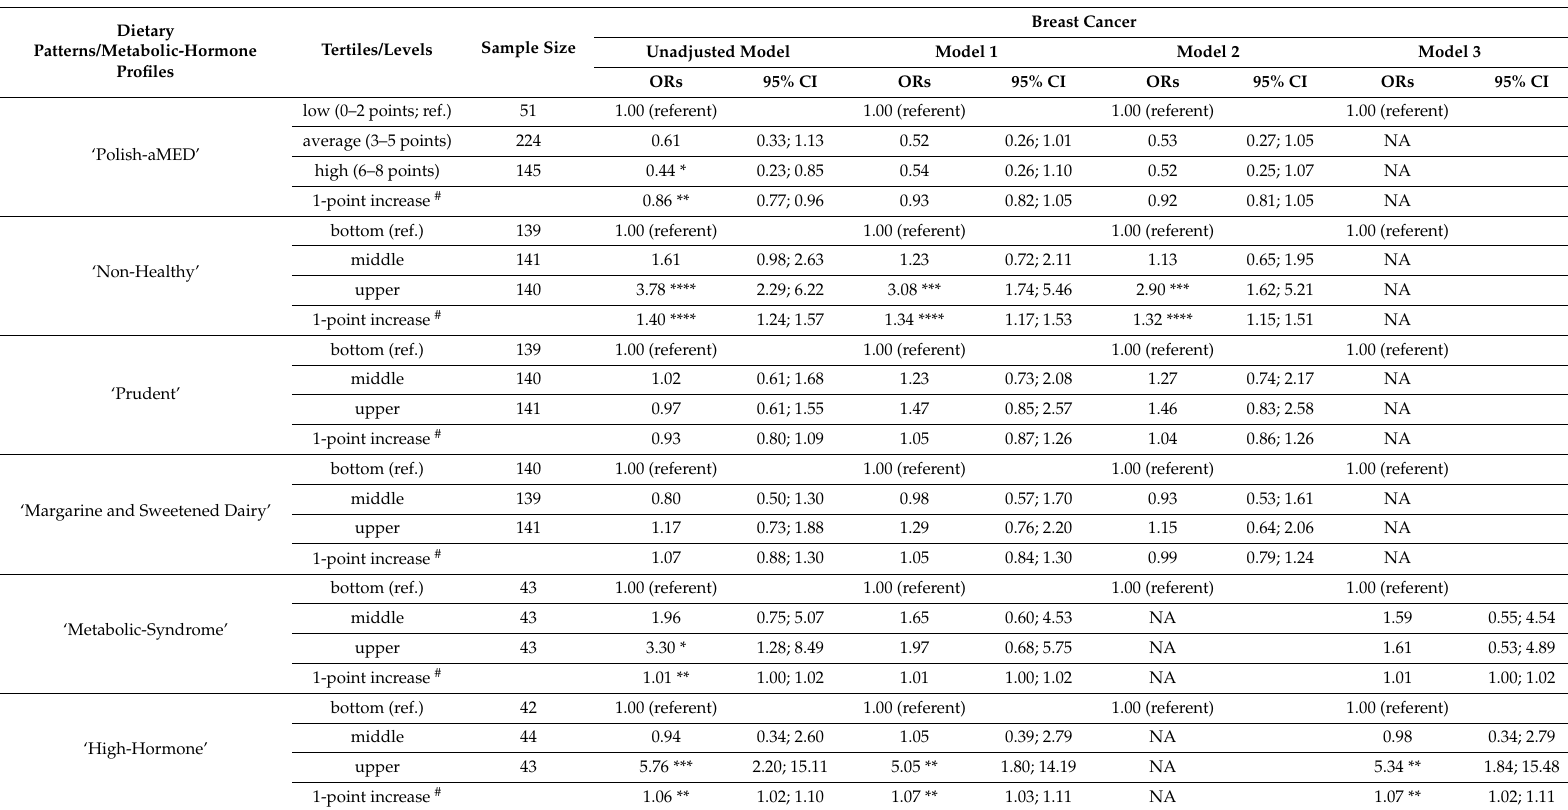
Table 6. Odds ratios (ORs) and 95% confidence interval (95% CI) of breast cancer by adherence to the dietary patterns ( n = 420) and metabolic-hormone profiles ( n = 129). Dietary Patterns/Metabolic-Hormone Profiles